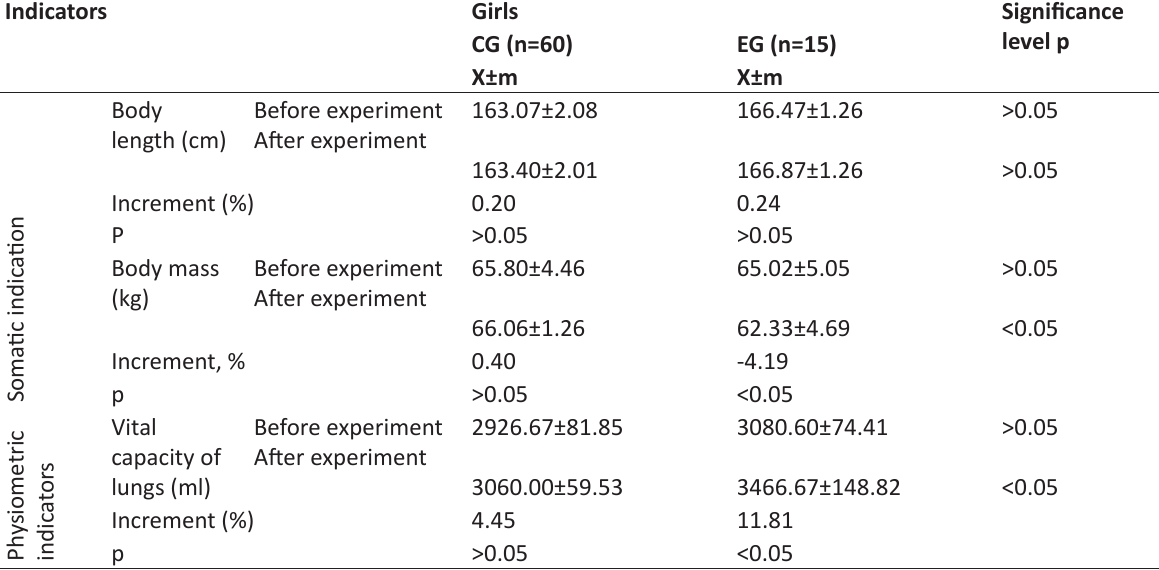
Table 1. Dynamic of control and experimental girl students’ indicators in pedagogic experiment (3 rd year)